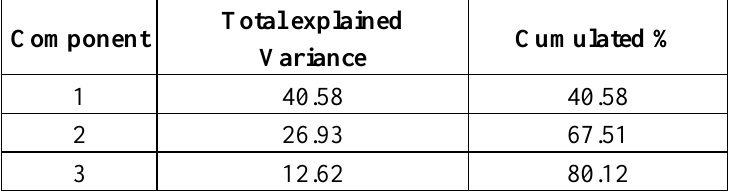
Table 8. Cumulated explained variance (in